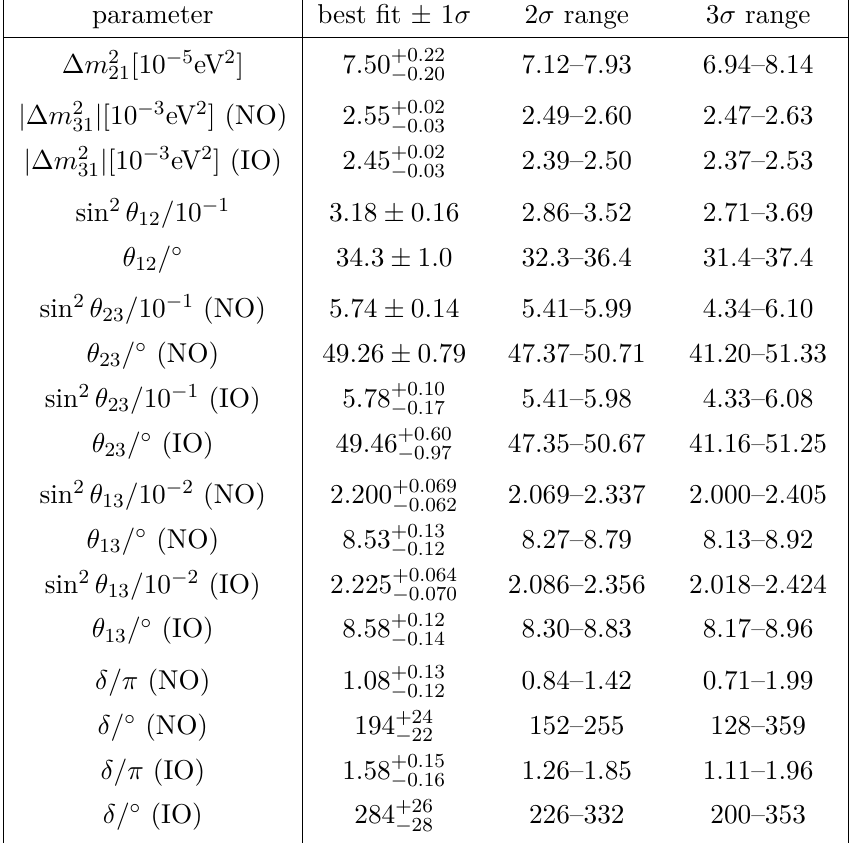
Table 3 . Neutrino oscillation parameters summary determined from the global analysis. The ranges for inverted ordering refer to the local minimum for this neutrino mass